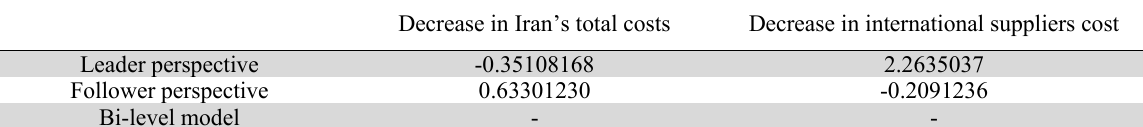
Percentage of decrease provided by the bi-level